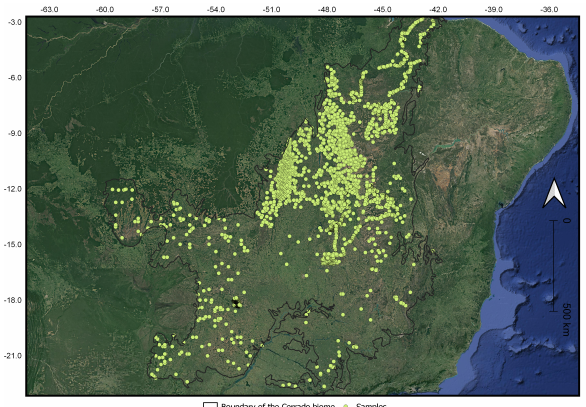
Figure 1. Distribution of the reference samples (n = 2828) across Cerrado biome.